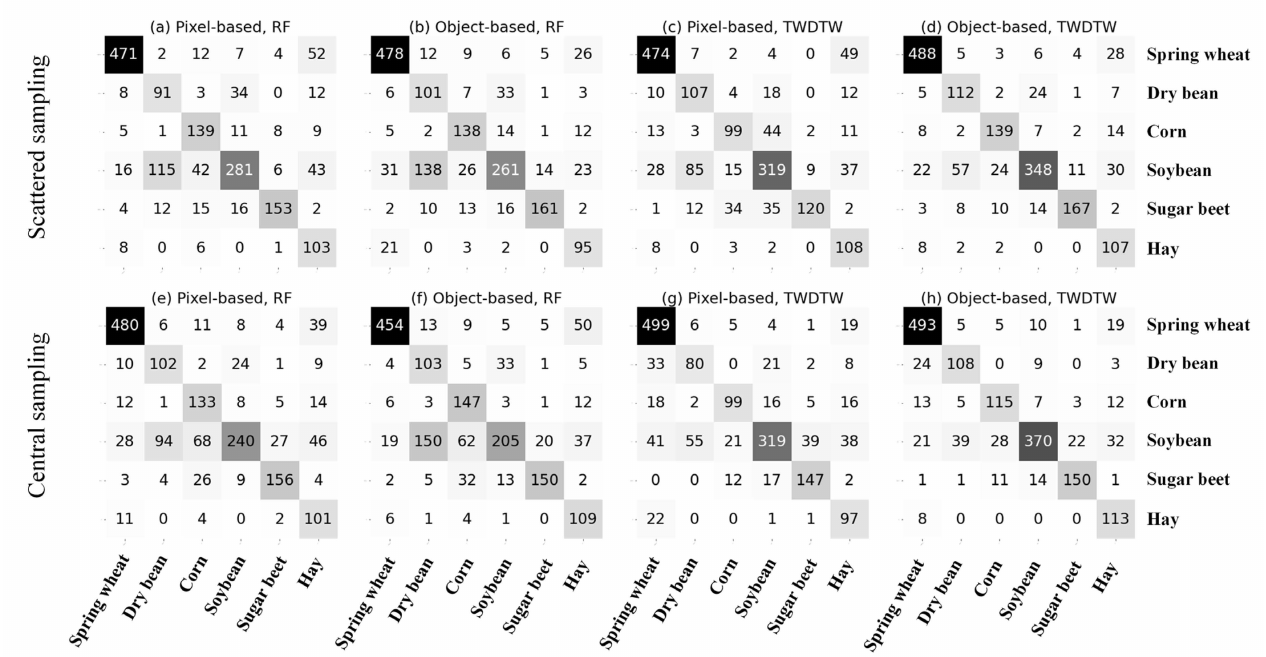
Figure 10. Confusion matrixes under different sampling strategies, perspectives, and classifiers. RF and TWDTW are the abbreviations of Random Forest and Time-Weighted Dynamic Time Warping,